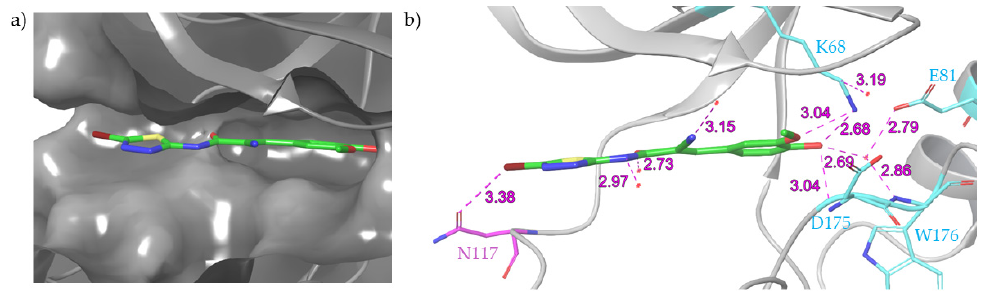
Figure 10. Binding mode and key interactions between the most promising SRPIN803-rev derivative and CK2 α . ( a ) Crystal structure of the lead compound in the series of SRPIN803-rev compounds (compound 4 in the paper) bound to CK2 α (PDB: 6RFE). ( b ) Ribbon depiction of structure highlighting the key binding interactions and the unusual binding mode of the compounds: the inhibitor protrudes out of the active site past the hinge region. Residues involved in hydrogen bonding with the ligand are shown in cyan; residues involved in halogen bonding are shown in magenta; bond distances are displayed in Å.